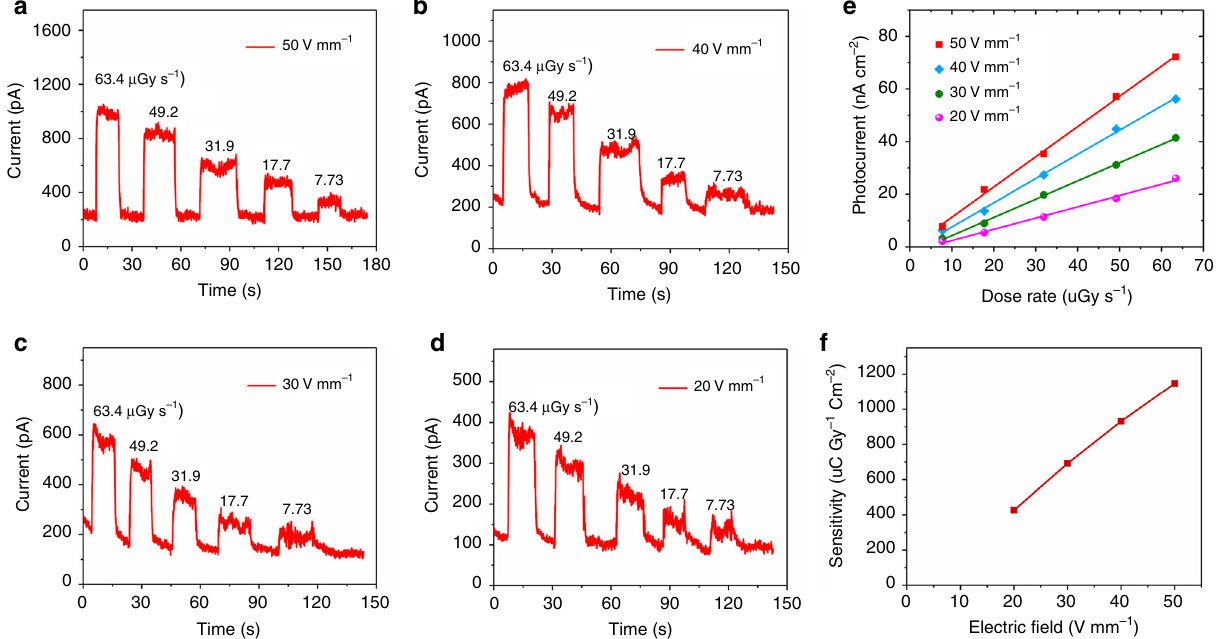
Fig. 6 Thermal stability measurement of the Cs 3 Bi 2 I 9 PSC detector at 100 °C. a – d ON/OFF photocurrent response under various electric fi eld and dose rates of the Cs 3 Bi 2 I 9 SC X-ray detector. e X-ray generated photocurrent density versus dose rate under different applied electric fi eld. f Sensitivity under different electric fi eld of the Cs 3 Bi 2 I 9 PSC X-ray